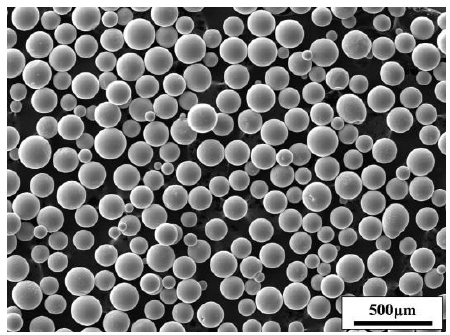
Figure 3. SEM morphology of Ti-6Al-4V powder.